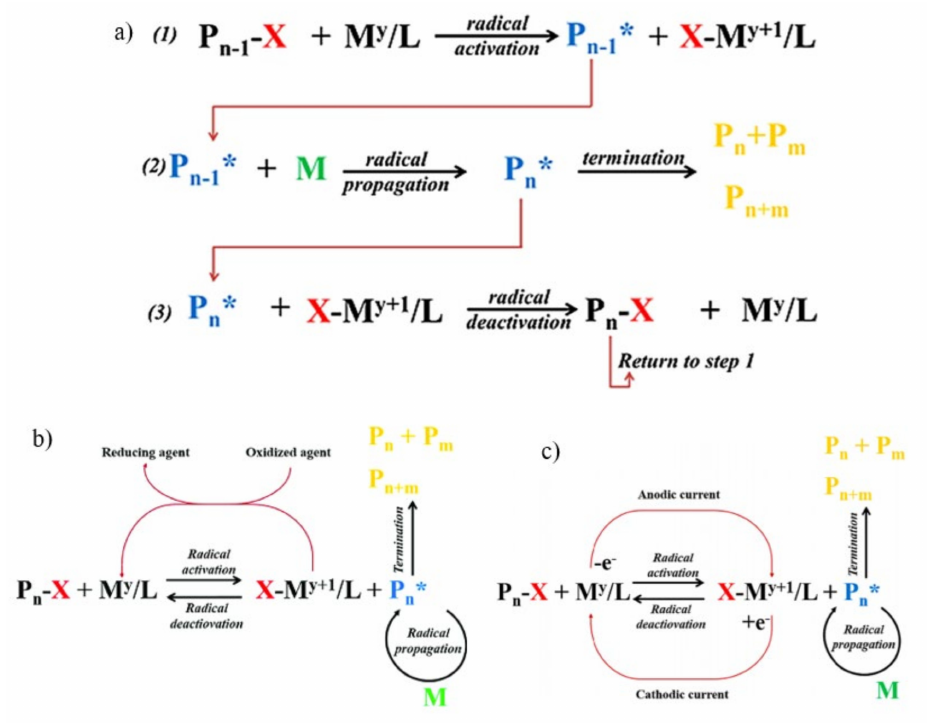
Figure 2. General mechanism of ( a ) traditional atom transfer radical polymerization in three simple steps; ( b ) AGET-ATRP; ( c ) SI-eATRP